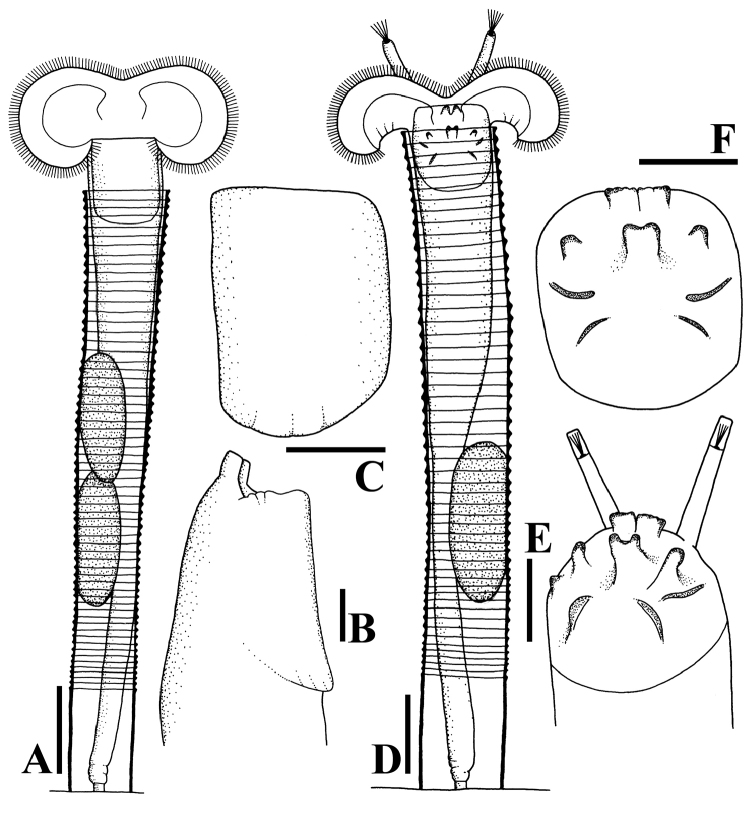
Line drawings of habitus and dorsal plate. A–CLimniaslenis sp. n. D–FLimniasnovemceras sp. n. Scale bars: 50 µm (A, D); 25 µm (B, C, E, F).